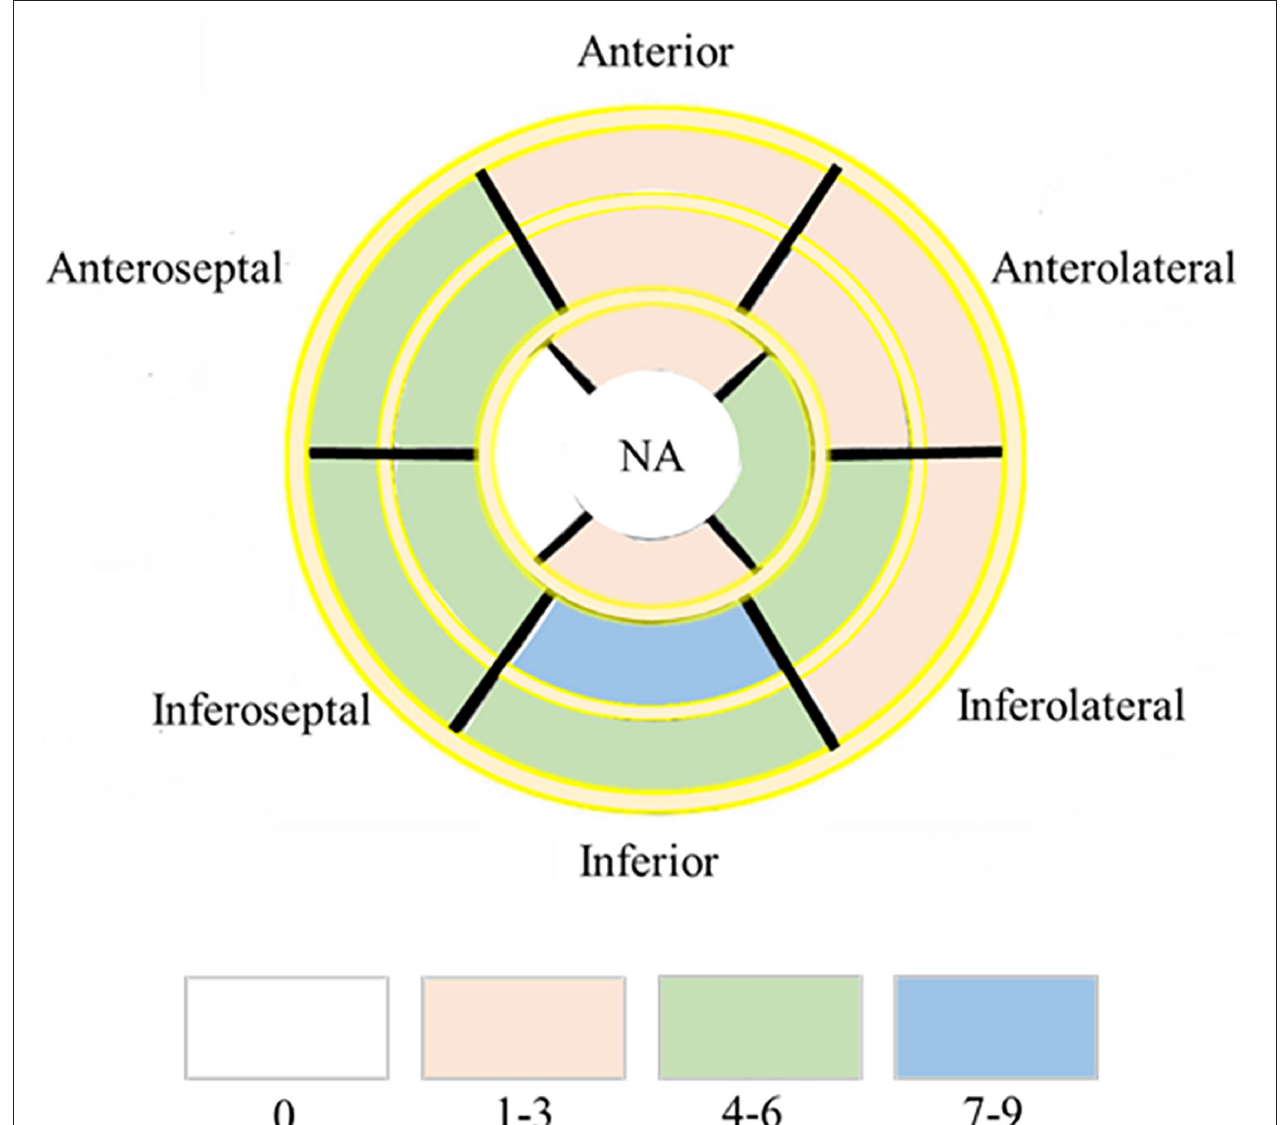
FIGURE 2 | Dominant location and distribution of myocardial fibrosis segments in the AHA 16 segments’ model. Number of LGE distributed in AHA 16 segments’ model in 41/47 HIV infected patients. NA, not applicable.